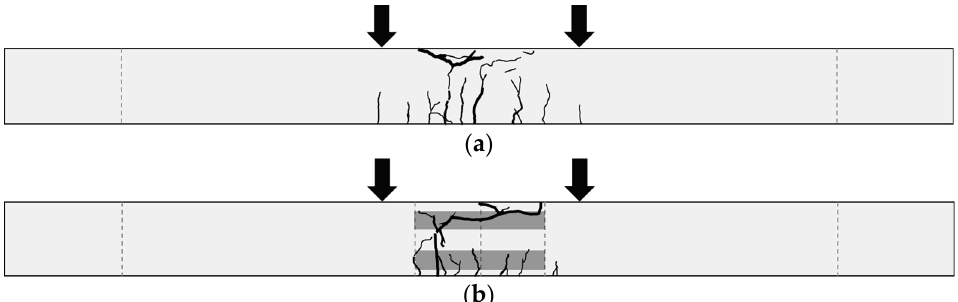
Figure 9. Crack propagation of flexural test specimens: ( a ) MCF; ( b ) PCF. The cracks and failure modes of specimens for the shear tests are shown in Figure 10.